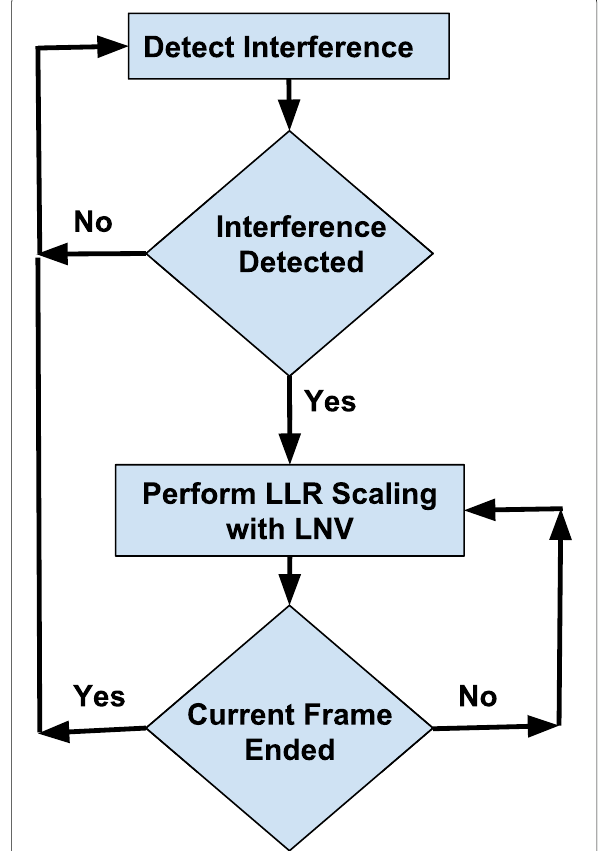
Fig. 6 Flow chart of interference detection and LLR scaling.